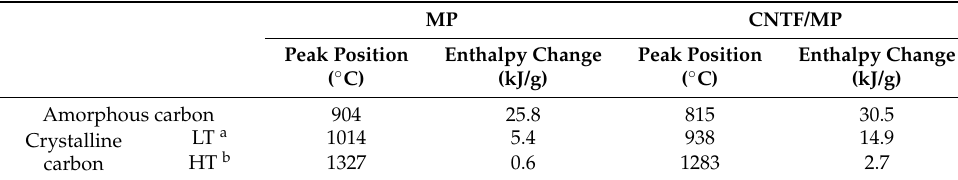
Figure 9. DSC curves of MP and CNTF/MP composites. Table 3. The data of DSC curves of MP and CNTF/MP as shown in Figure